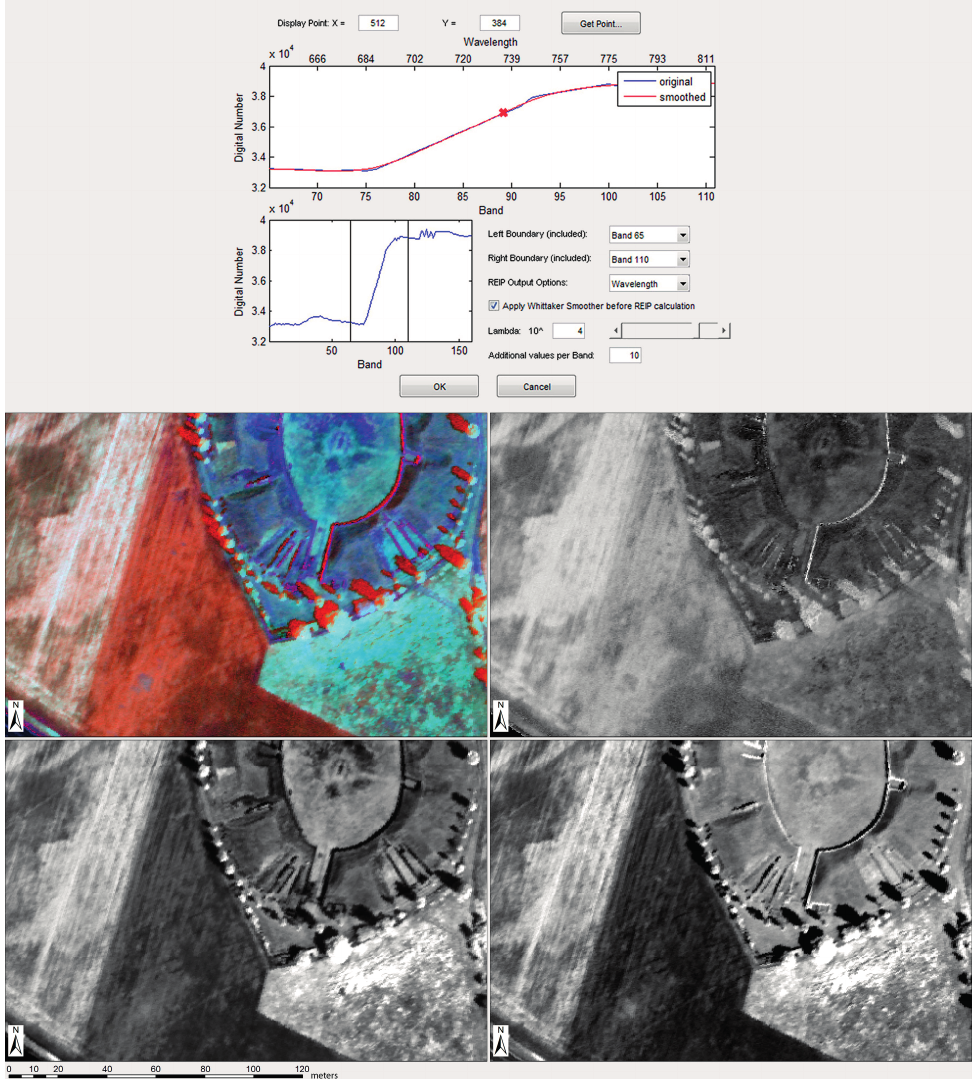
Figure 7. Calculation of (red edge) inflection points (REIP) in the spectral domain using ARCTIS. The screenshot ( top ) displays the settings panel for selecting the range of search and the oversampling using the Whittaker smoother. The four images below the GUI show different outputs: ( top left ) a false color composite of the three REIP outputs, ( top right ) wavelength position of maximum gradient, ( bottom left ) reflectance gradient at REIP, and ( bottom right ) reflectance level for the wavelength of maximum